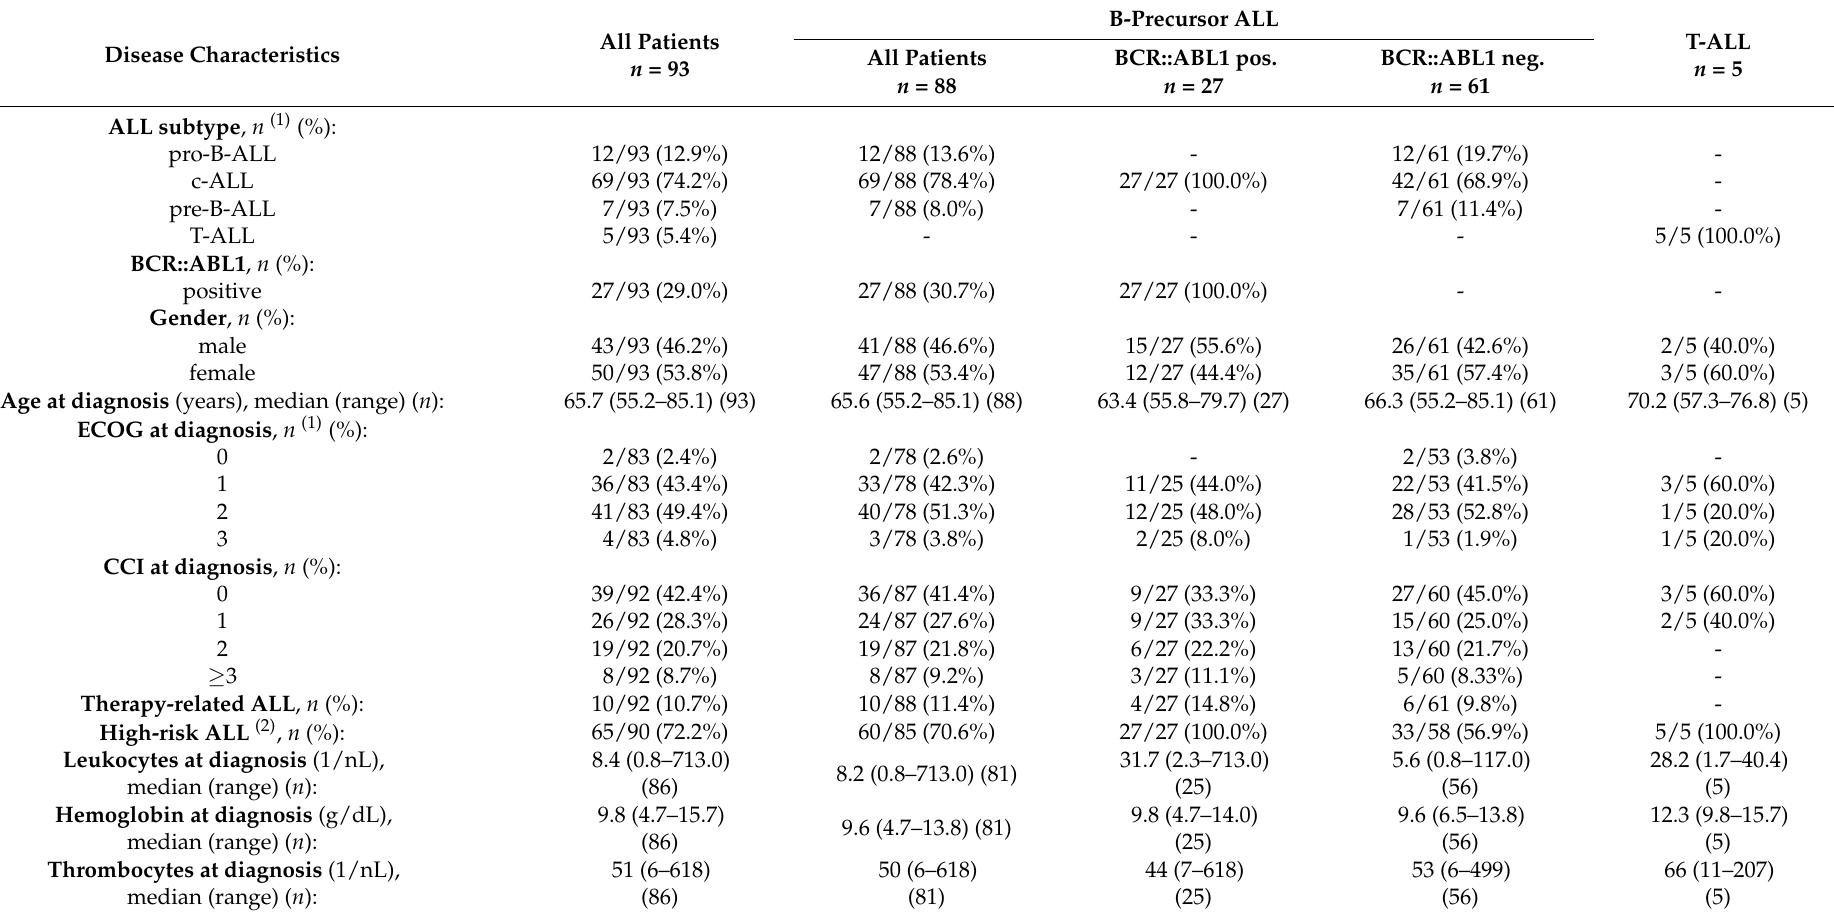
Table 1. Disease characteristics of the cohort of intensively treated elderly ALL patients (>55 years at diagnosis). Disease Characteristics